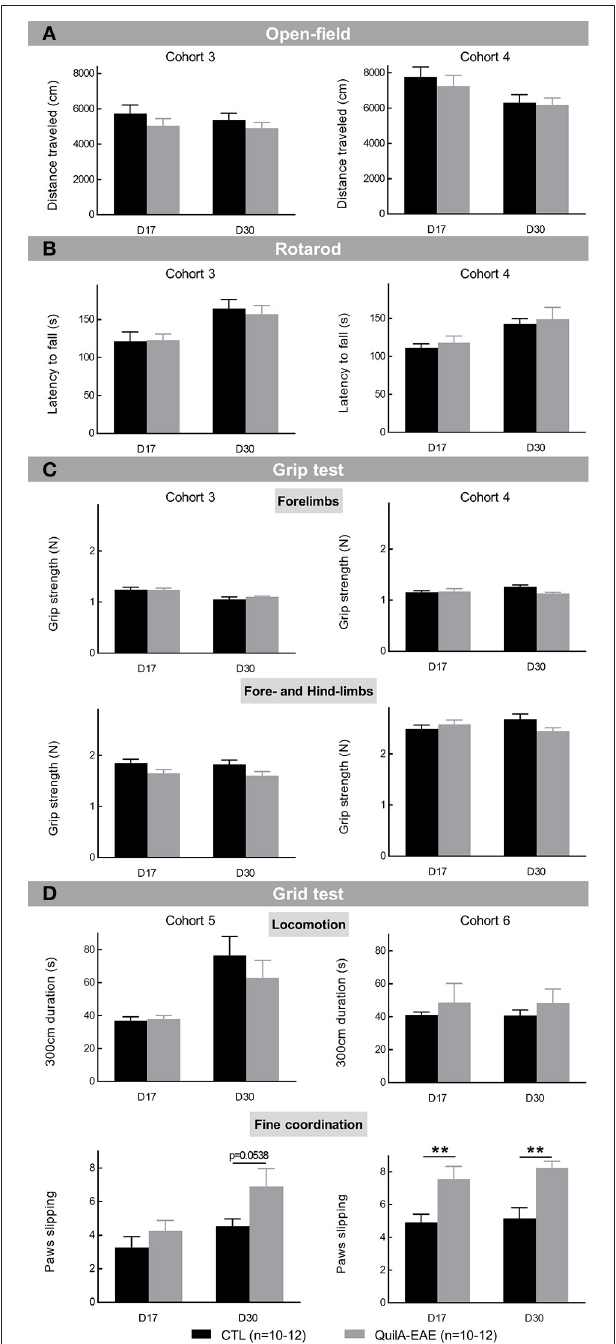
FIGURE 2 | Evaluation of motor behaviors in mice immunized with MOG 35 − 55 (QuilA-EAE) and their controls (CTL) at post-induction Day 17 (D17) and D30. (A) Evaluation of spontaneous locomotor activity using the open-field test. Locomotion was evaluated using the total distance traveled ± SEM for the overall 15min session. (B) Rotarod performance was expressed as the mean latency to fall ± SEM for the four rotarod sessions performed by each mouse. (C) Muscular strength performance was expressed as the mean grip strength ± SEM for the five sessions performed by each mouse. Top: forelimb muscular